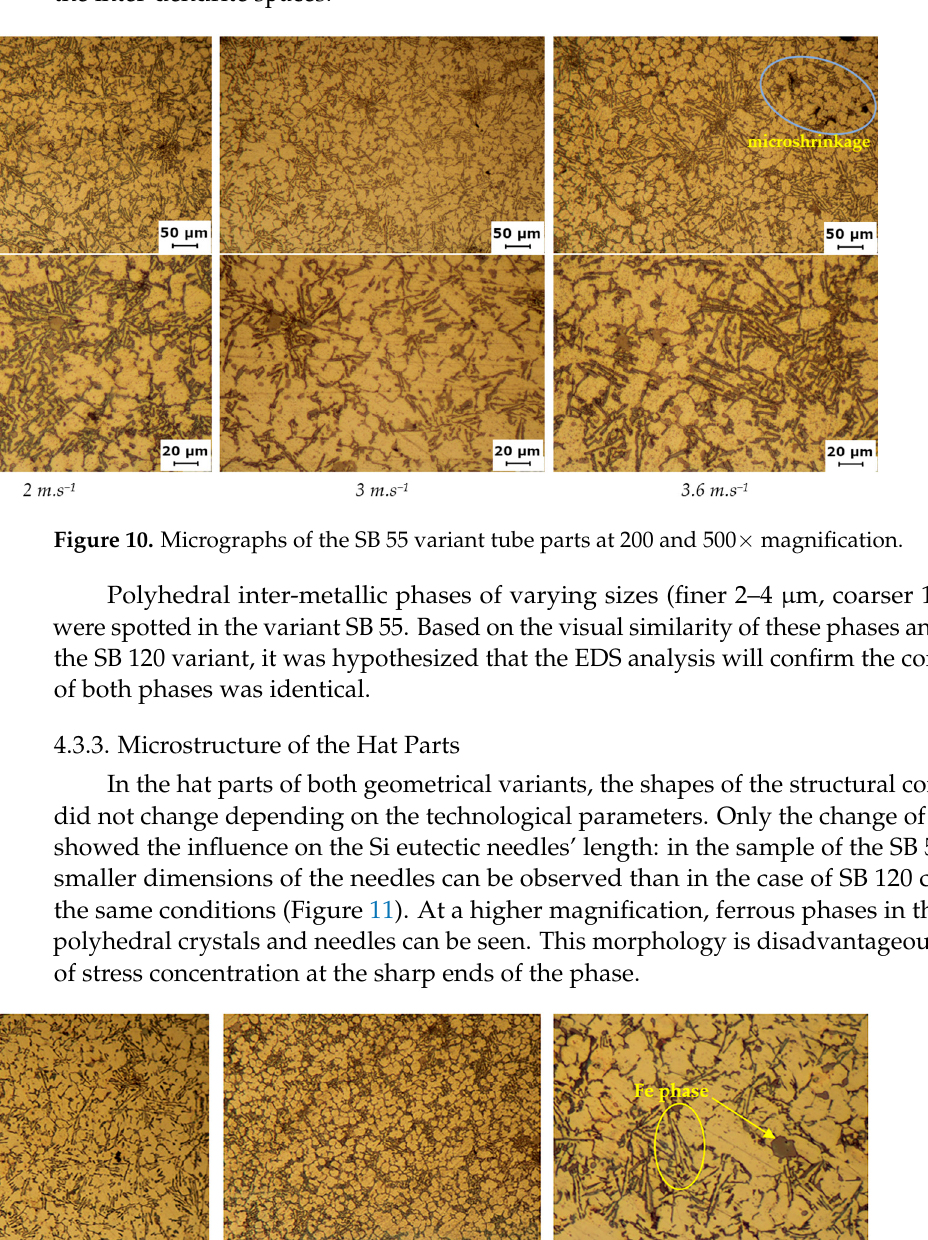
Figure 11. Hat part microstructure: ( a ) SB 120—2 m.s − 1 ; ( b ) SB 55—2 m.s − 1 . ( c ) Plates and polyhedrons of Fe phase.